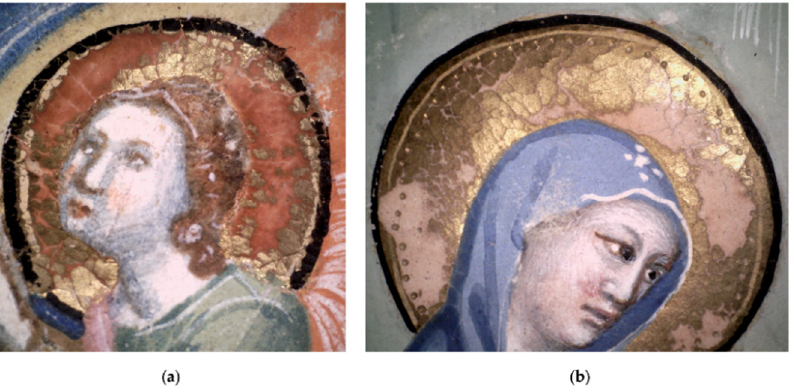
Figure 8. Images of 8r showing ( a ) angel in the marginal decoration; ( b ) Virgin Mary in the initial